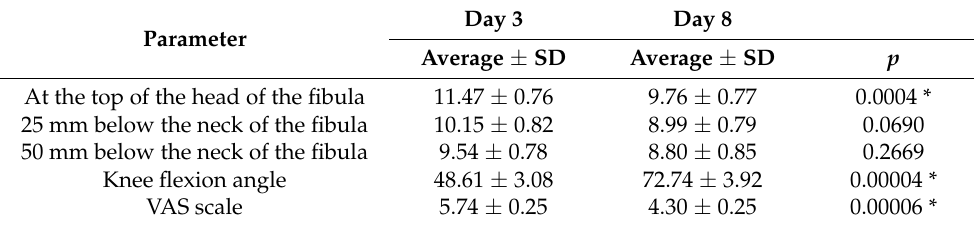
Table 2. The results obtained in the subgroups that received Kinesio Taping. Parameter